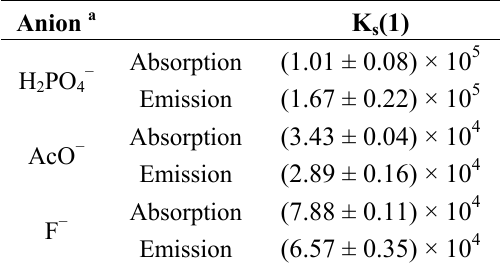
Table 1. Binding constants of probe 1 with various